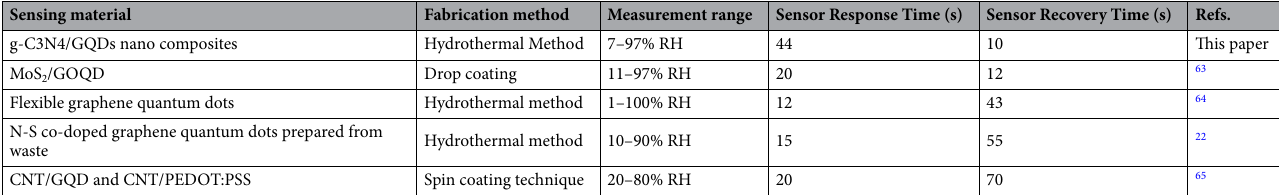
Table 5. performance of the proposed sensor in comparison with other reported sensors in previous